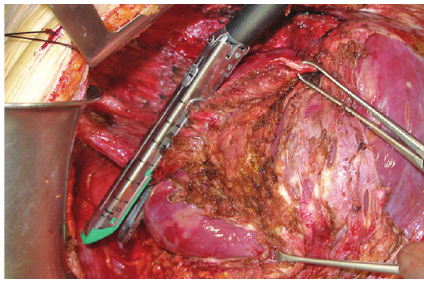
Figure 2: Partial resection of the diaphragm by using a linear stapler.